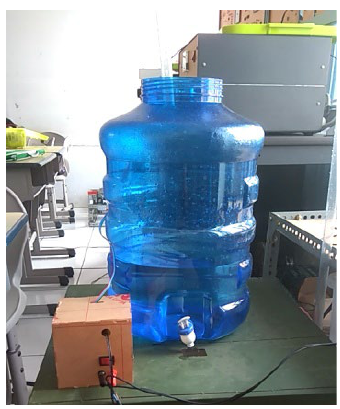
Figure 20. Display of Android during the first test